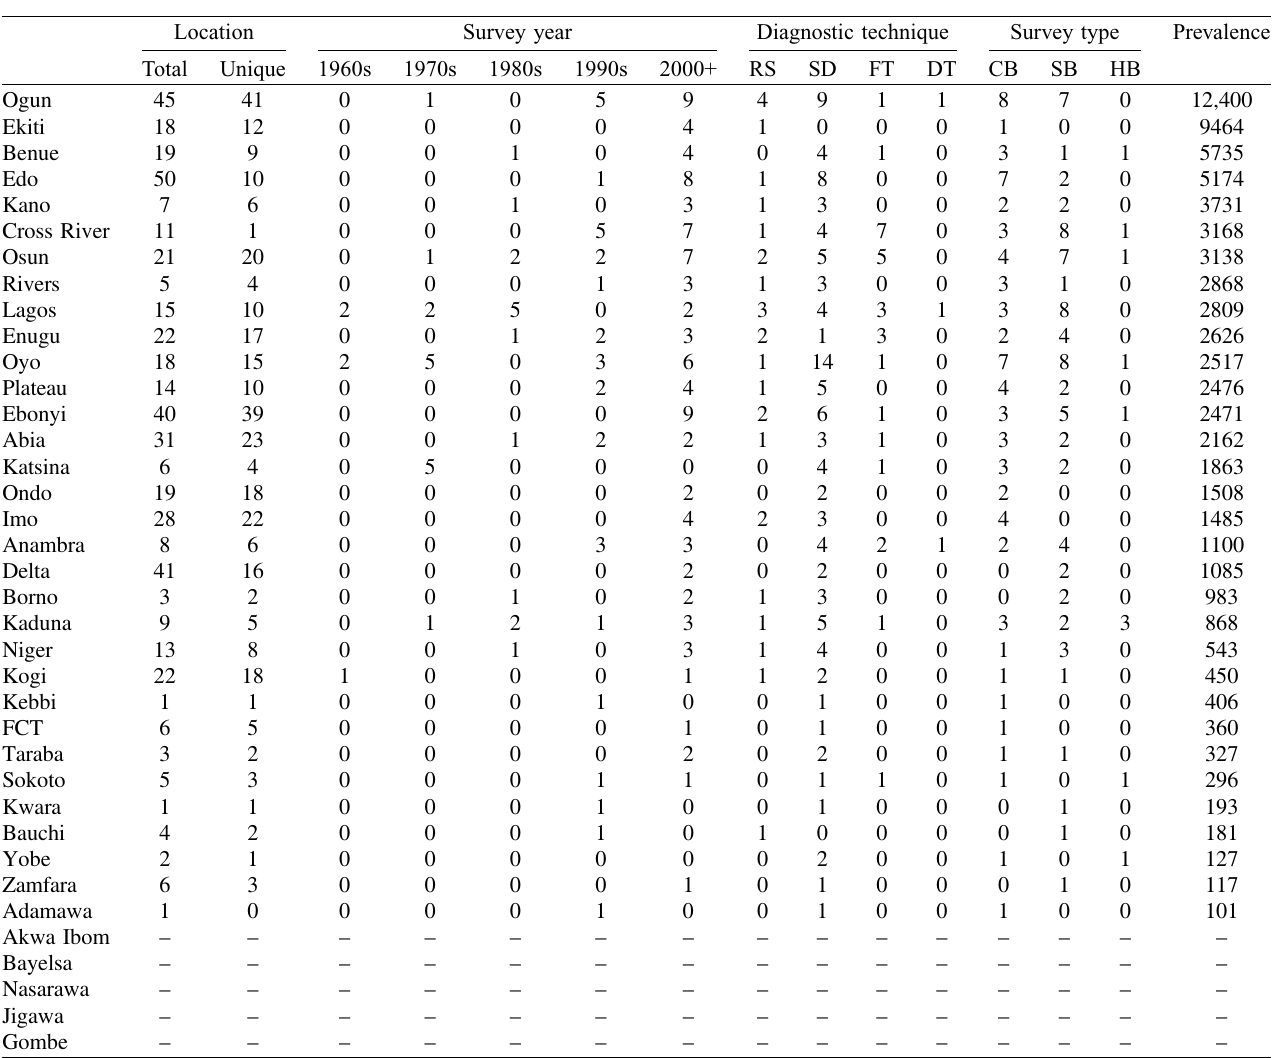
Table 1. Overview of the survey data included in the analysis strati fi ed by state.